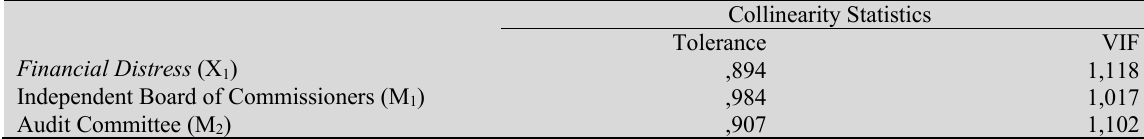
The summary of collinearity statistics